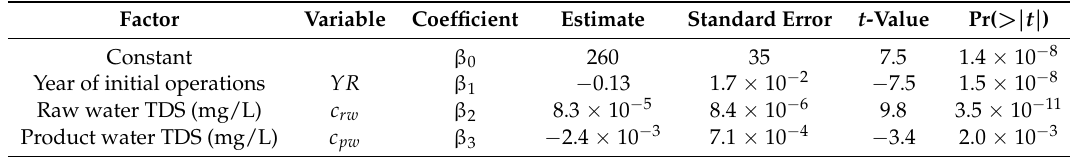
Table 5. Multiple linear regression results for the municipal-scale model of desalination operations ( n = 36) revealed a reasonable model fit with highly significant coefficients. Values have been rounded to two significant figures.